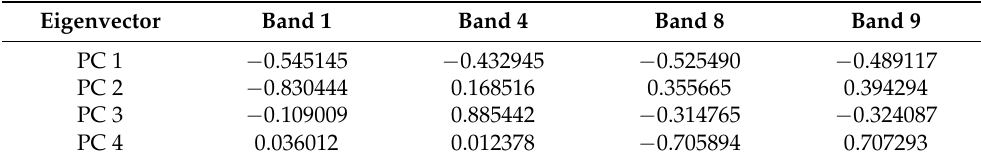
Table 7. Eigenvector matrix of selected bands for mapping propylitic zone derived from SPCA.